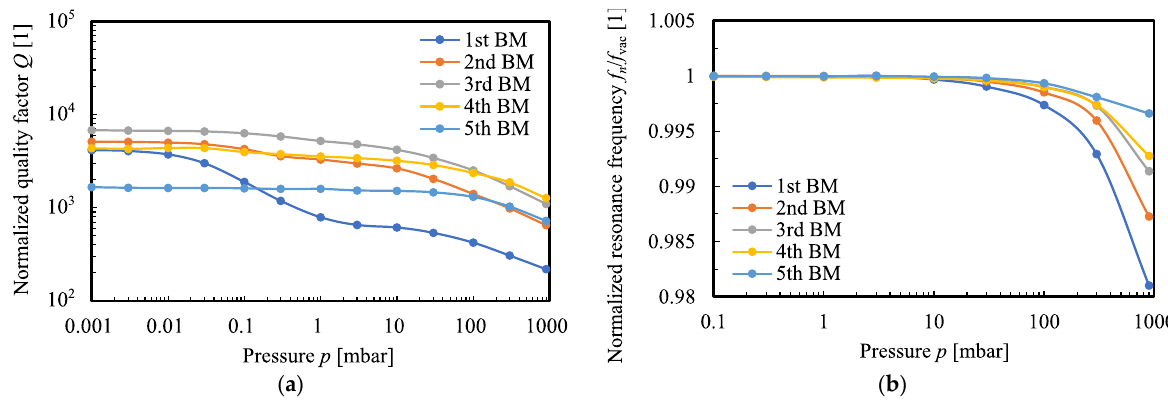
Figure 4. Quality factor plot ( a ) and normalized resonance frequency plot ( b ) as function of the ambient pressure of MEMS oscillator BO3 for the first five bending modes. The resonance frequency is normalized on the high vacuum value (at p = 0.001 mbar). All data are recorded for a gap width of h = 550 µm in an N 2 atmosphere.